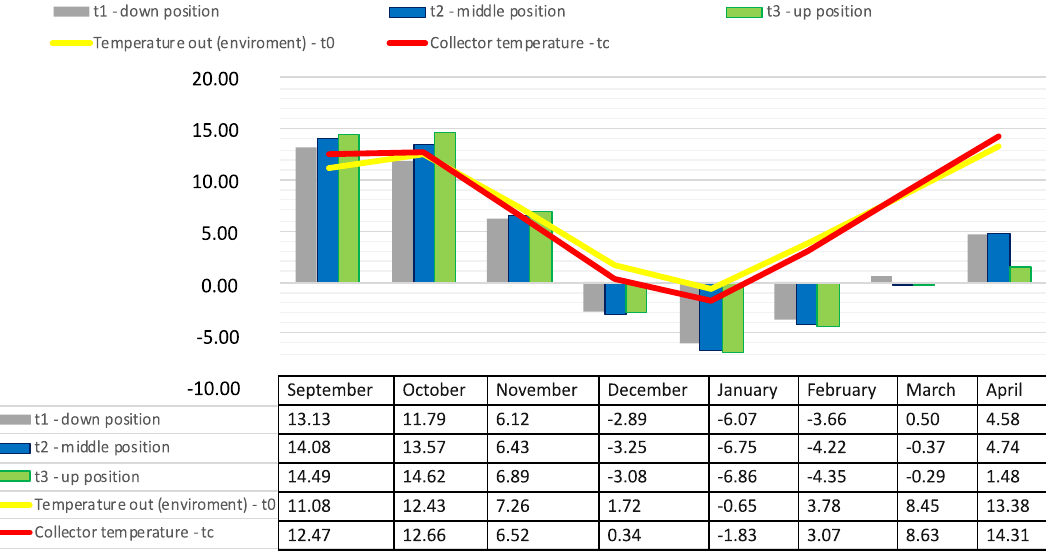
Figure 10. Temperature average throughout the collected time.